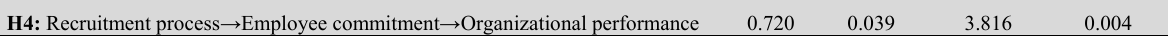
The summary of the results of the fourth hypothesis H4: Recruitment process → Employee commitment → Organizational performance